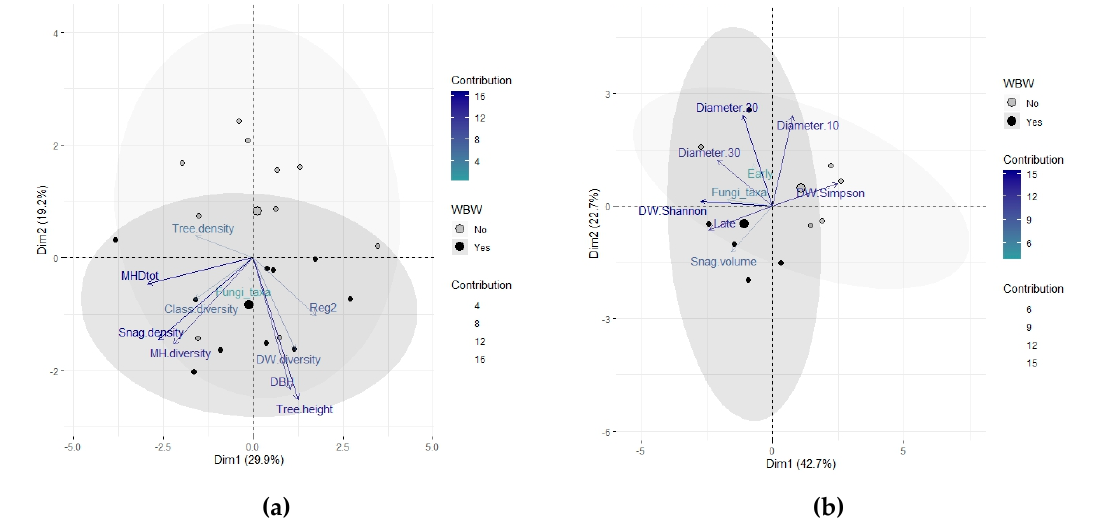
Figure 5. Rarefaction species richness curve (N o of saproxylic fungi taxa) as a function of deadwood (“DW”) volume (m 3 /ha) in WBW (black, “WBW yes”) and non-WBW territories (grey, “WBW no”).